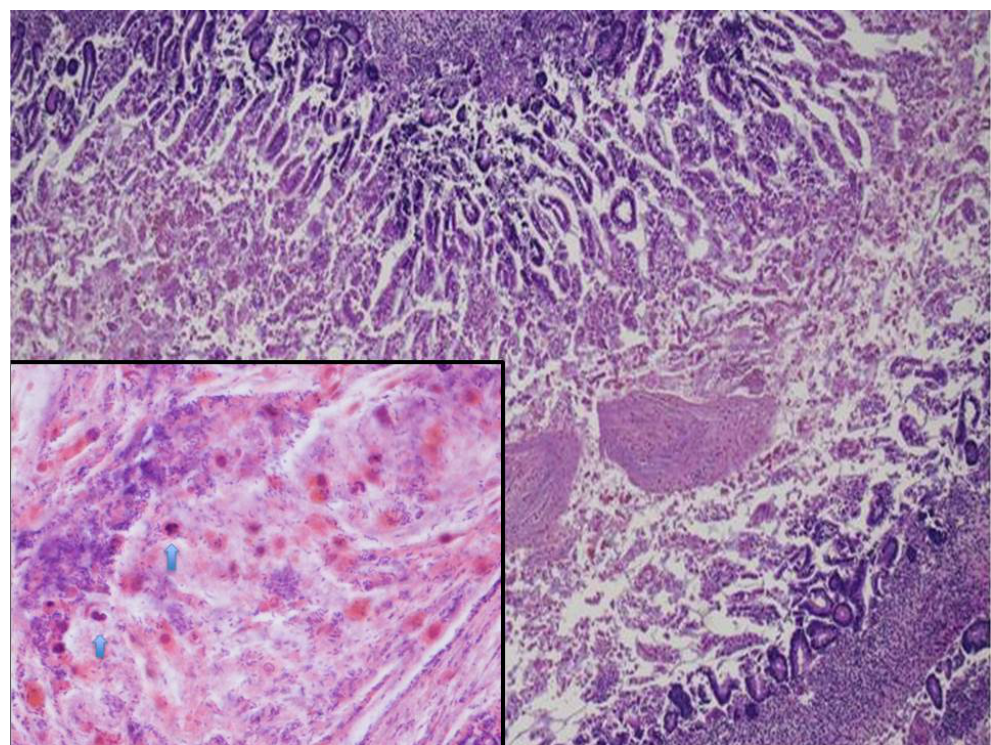
Figure 2. Fetal small intestine: intestinal lumen filled with mucus (HE staining 4×). In the mucoid material (frame) there were neutrophils (blue arrows) intermixed with abundant clusters of rod-shaped bacteria (HE staining 20×).